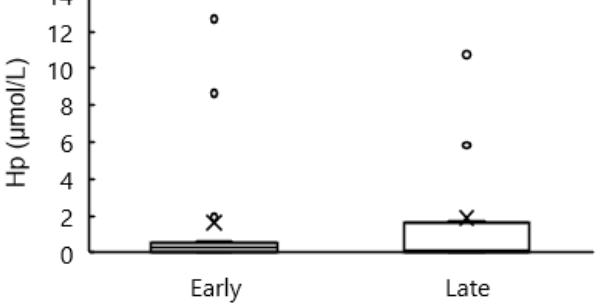
Figure 14. Blood haptoglobin (Hp) concentration at 0 wk relative to calving for cows classified into the early group (Early) and the late group (Late). Early = cows with endometrial inflammation converged within 4 wk, n = 17; Late = cows with endometrial inflammation converged at or after 5 wk, n = 16. The week of calving is defined as 0 wk. G = group effect; W = week effect; GW = group-by-week interaction. Means are represented by cross; outliners are represented by white circles; upper line represented upper quartile; middle line represented median; lower line represented lower quartile.